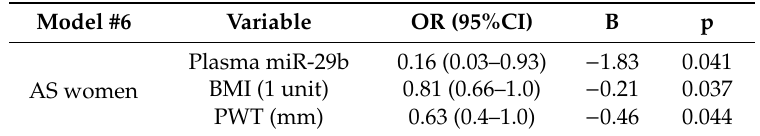
Table 3. Logistic regression predictive model of LVM normalization one year after aortic valve replacement in AS women